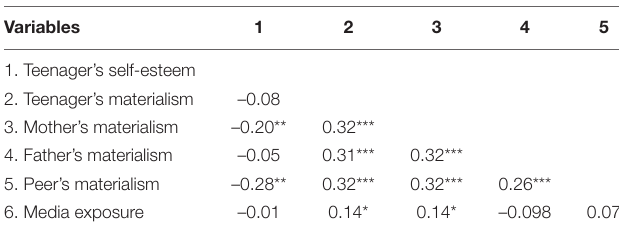
TABLE 1 | Correlations of variables (Study